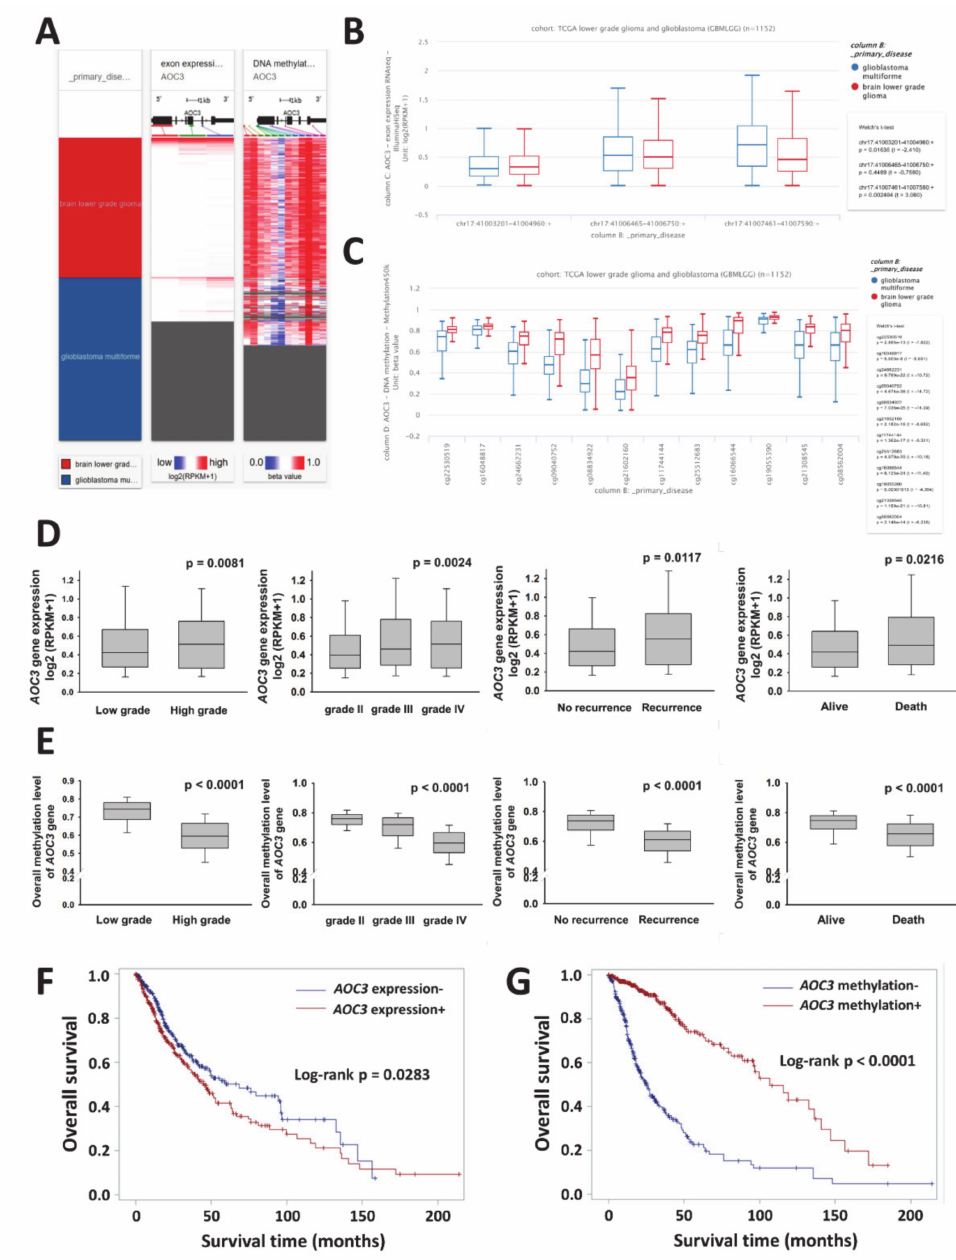
Figure 1. Identification of the predicted potential of AOC3 in glioma from TCGA low-grade glioma and glioblastoma dataset. ( A ) AOC3 gene expression and methylation status in the glioma subgroups were analyzed and the level 3 data were downloaded from UCSC Xena. Three exons were used in AOC3 transcriptional dataset, and twelve methylation probes were utilized in the gene methylation profile study as described in the Section 2. Analyses of AOC3 exon expression ( B ) and DNA methylation ( C ) in subgroups of low-grade glioma and glioblastoma were performed using UCSC Xena. The levels of AOC3 exon expression ( D ) and methylation status ( E ) in di ff erent subgroups of gliomas were shown by box and whisker plots. Kaplan–Meier curves were performed with exon expression ( F ) and DNA methylation ( G ) datasets and showed association of AOC3 gene expression with overall survival in glioma patients. p < 0.05 was considered statistically significant. Abbreviations: TCGA: the cancer genome atlas; UCSC: University of California Santa